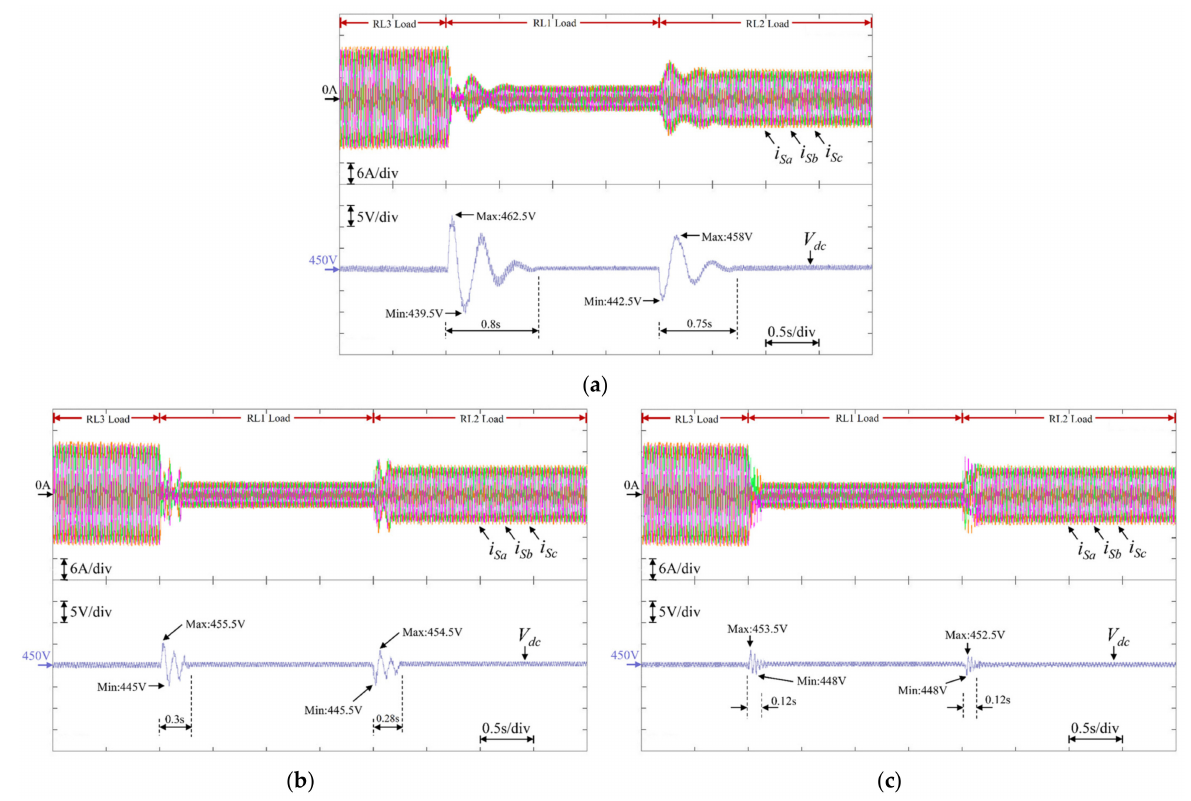
Figure 10. Experimental results under load variation in Case 2. ( a ) Response of grid currents and DC-link voltage of PI-controlled DSTATCOM; ( b ) Response of grid currents and DC-link voltage of FNN-controlled DSTATCOM; and ( c ) Response of grid currents and DC-link voltage of proposed WTSKFNN-controlled DSTATCOM.